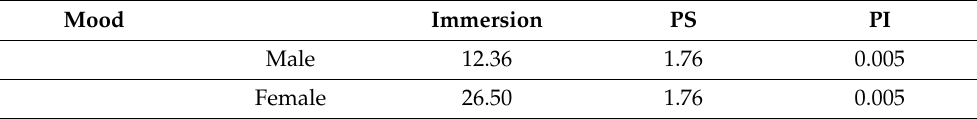
Table A3. There is a 75% chance of low Mood for the given values of Immersion setting PS and PI to their medians for participants who are not sick. The PI values are